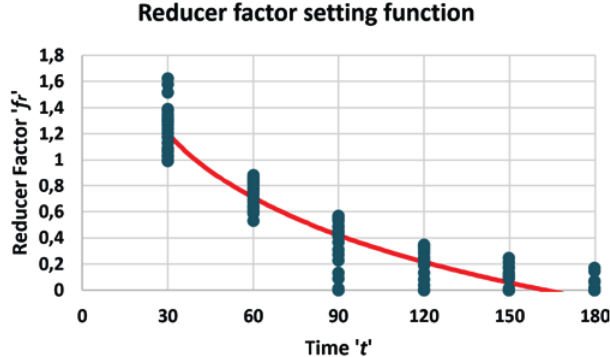
Function illustration that describes the reducer factor against the results achieved